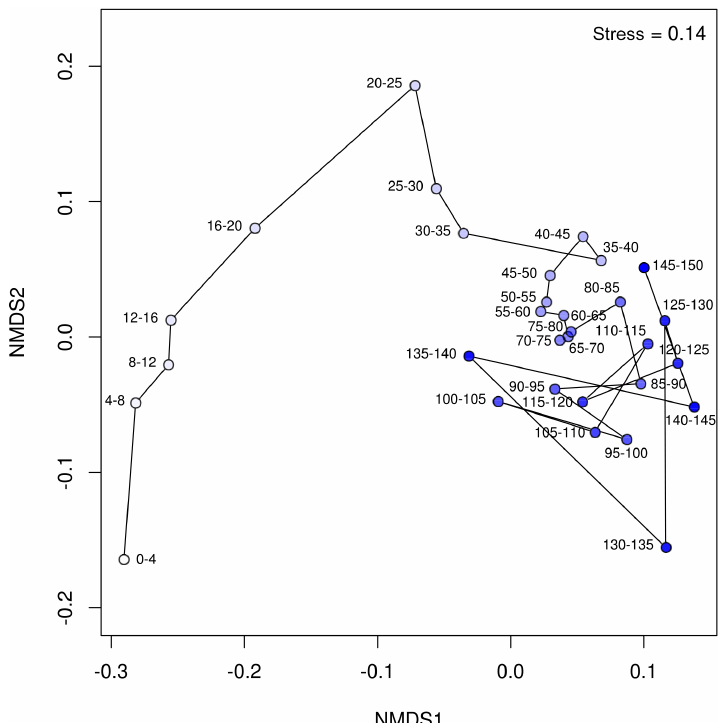
Figure 7. Non-metric multidimensional scaling ordination of the foraminiferal